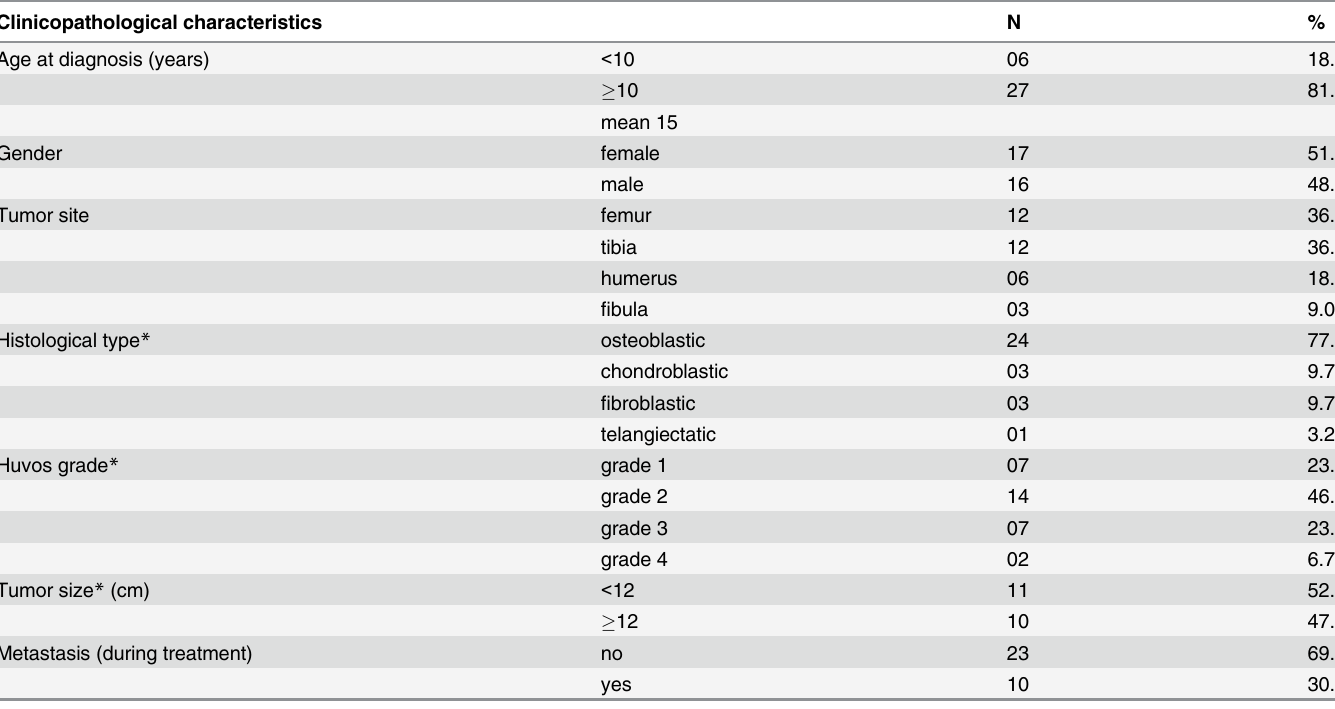
Table 1. Clinicopathological characteristics of the osteosarcoma population. Clinicopathological